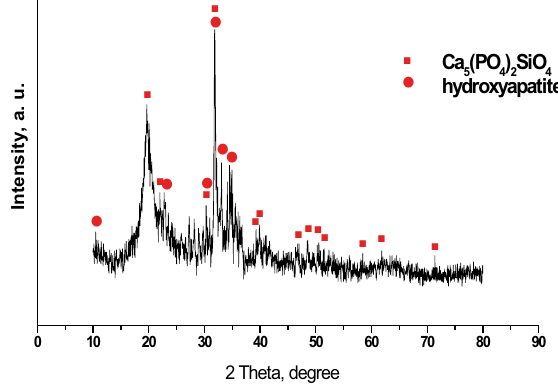
Figure 7. XRD of collagen-silicocarnotite (25:75 wt%) after 3 days immersion in